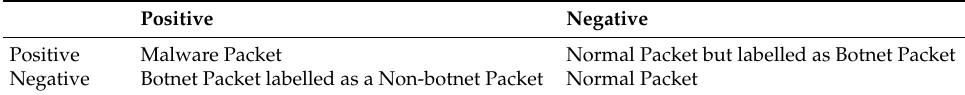
Table 1. Botnet classification confusion